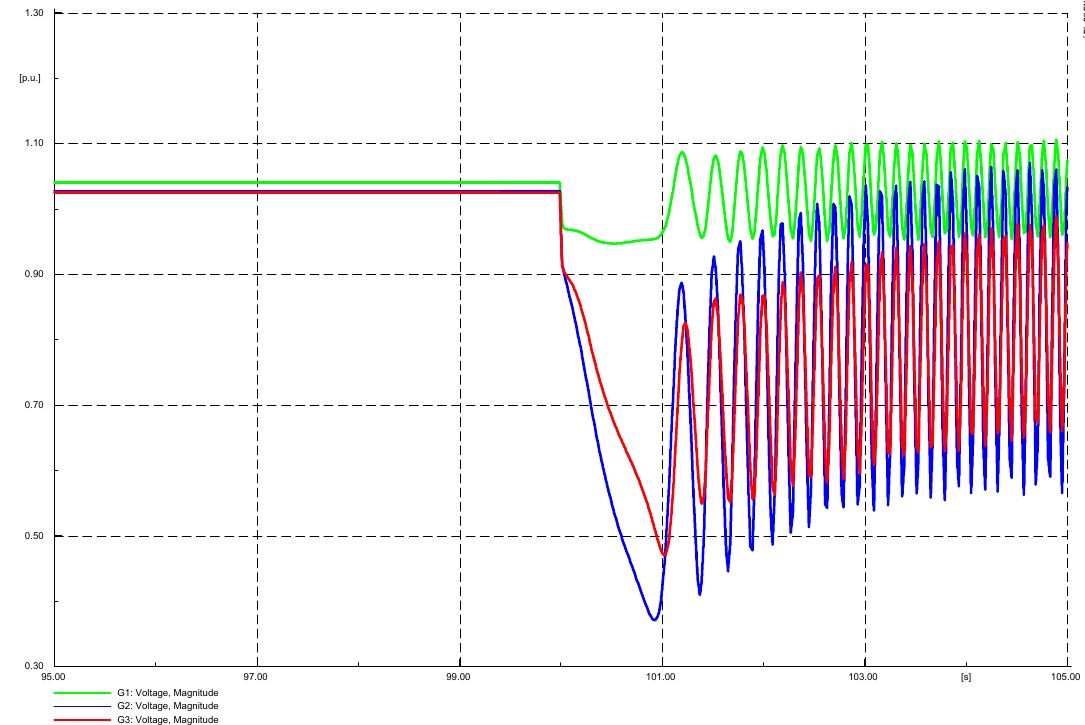
Figure 2. Voltage transient stability analysis results of bus 1, 2, and 3.